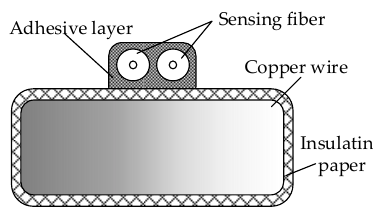
Figure 3. Cross-sectional view of fibre composite winding wire. Table 1. Parameters of epoxy resin adhesive.